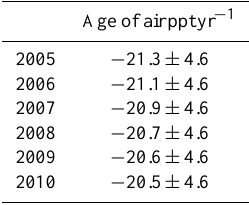
Table 2. The effective linear growth rates ( γ 0 ) in % yr − 1 of